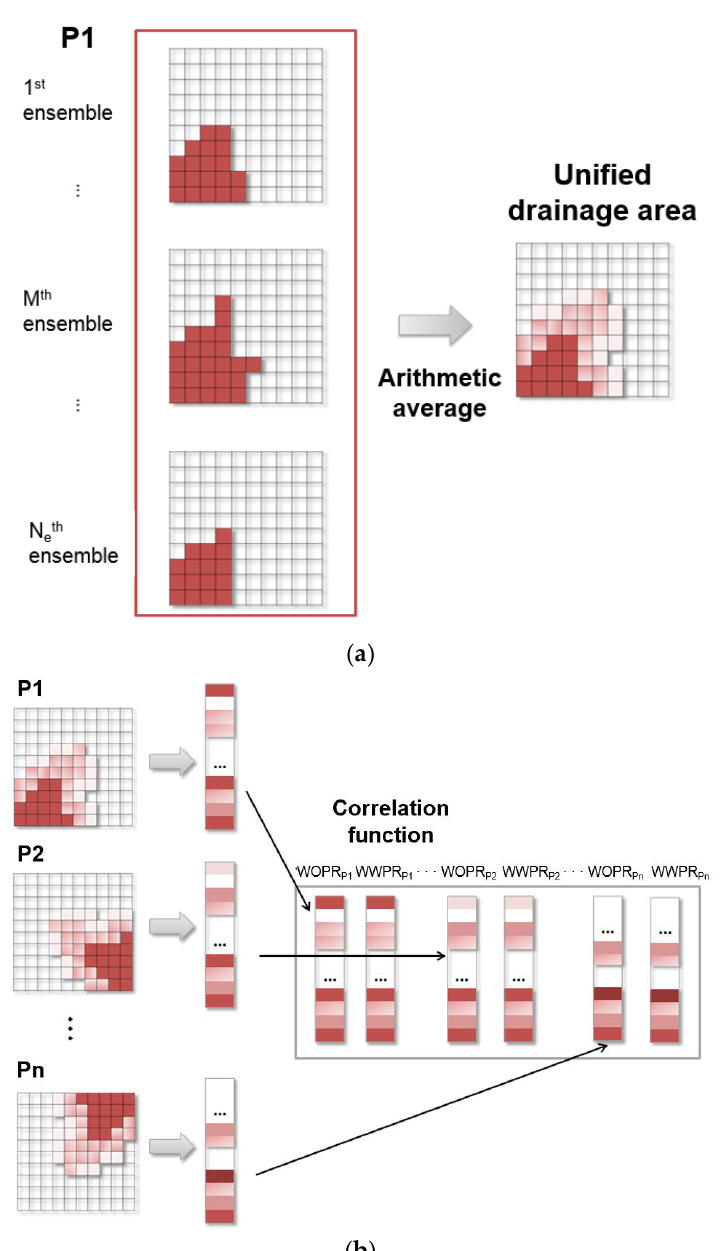
Figure 4. The concept of correlation function for drainage area: ( a ) Definition of drainage area for each production well; ( b ) Construction of correlation function. WOPR is well oil production rate, and WWPR stands for well water production rate. P represents ‘the production well’, and the subscripts 1 , 2 , and n mean the indication number for each production well.